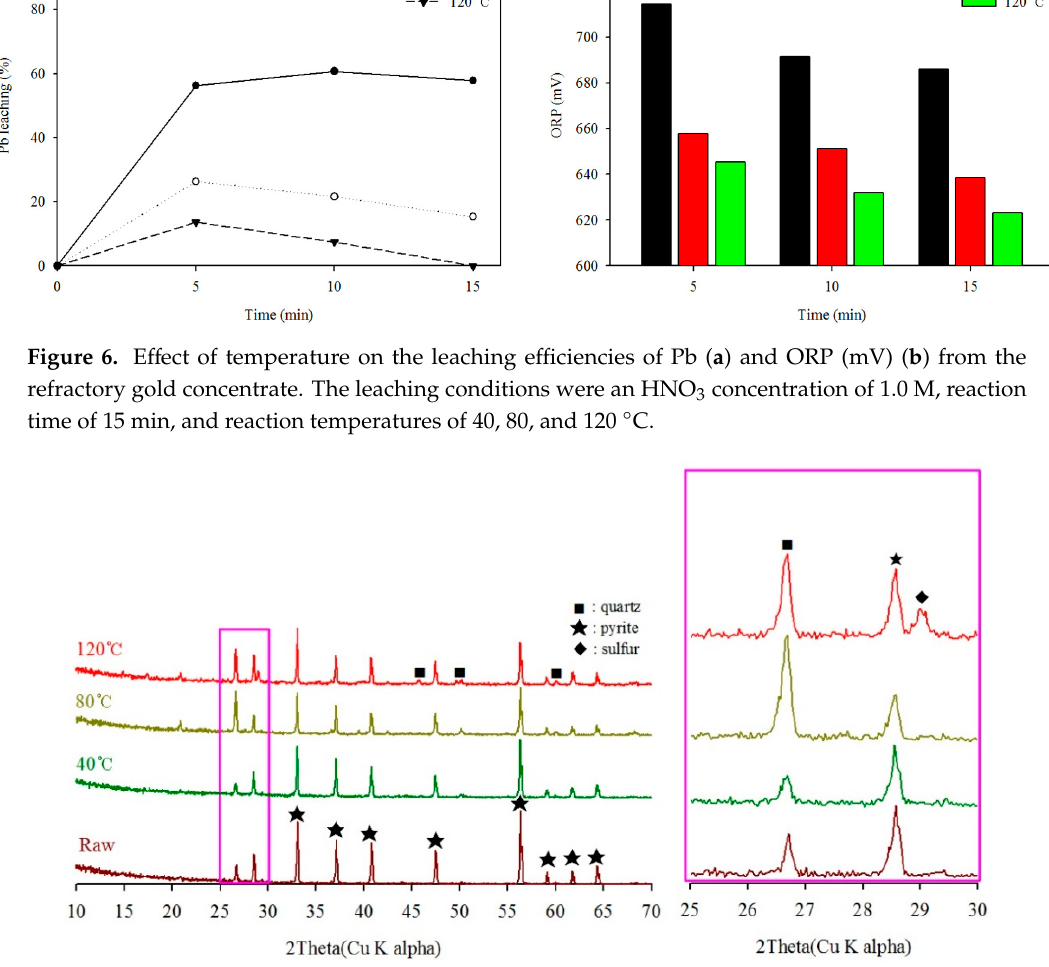
Figure 7. XRD patterns of raw and leach residue from nitric acid leaching at 40, 80, and 120 °C. The leaching conditions were an HNO 3 concentration of 1.0 M and a reaction time of 15 min.